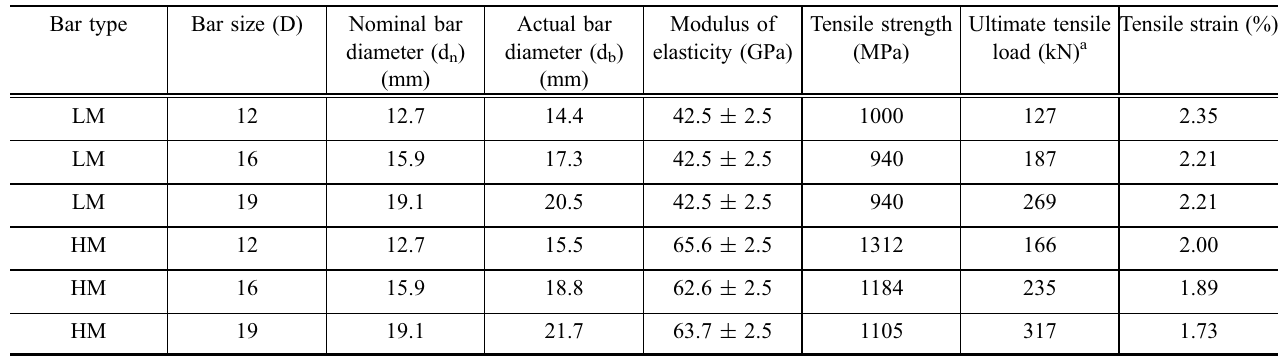
Table 2 Properties of GFRP